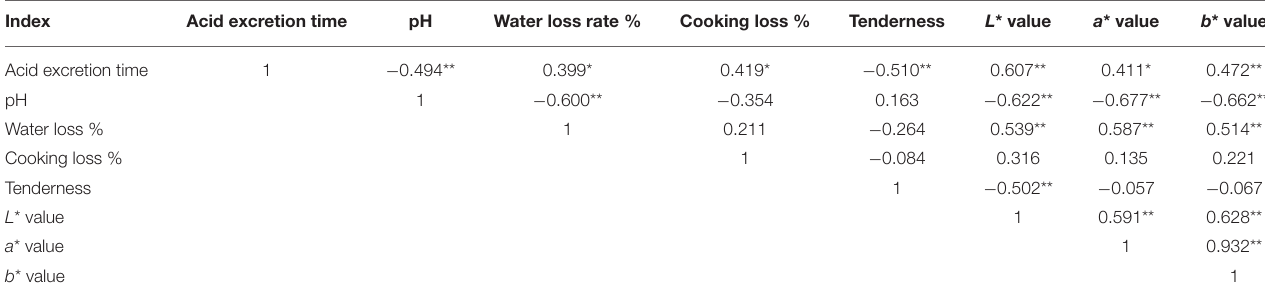
TABLE 4 | Correlation analysis of meat quality index in Yunling beef in the process of maturity.